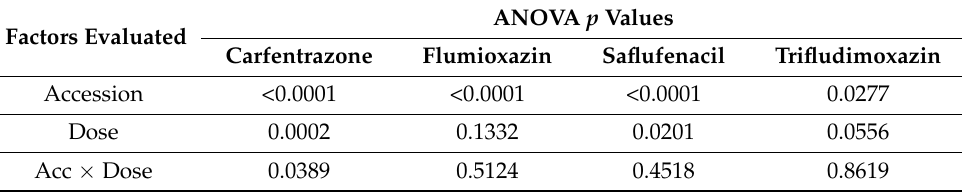
Table 3. p values from ANOVA for mortality 3 weeks after treatment with different PPO